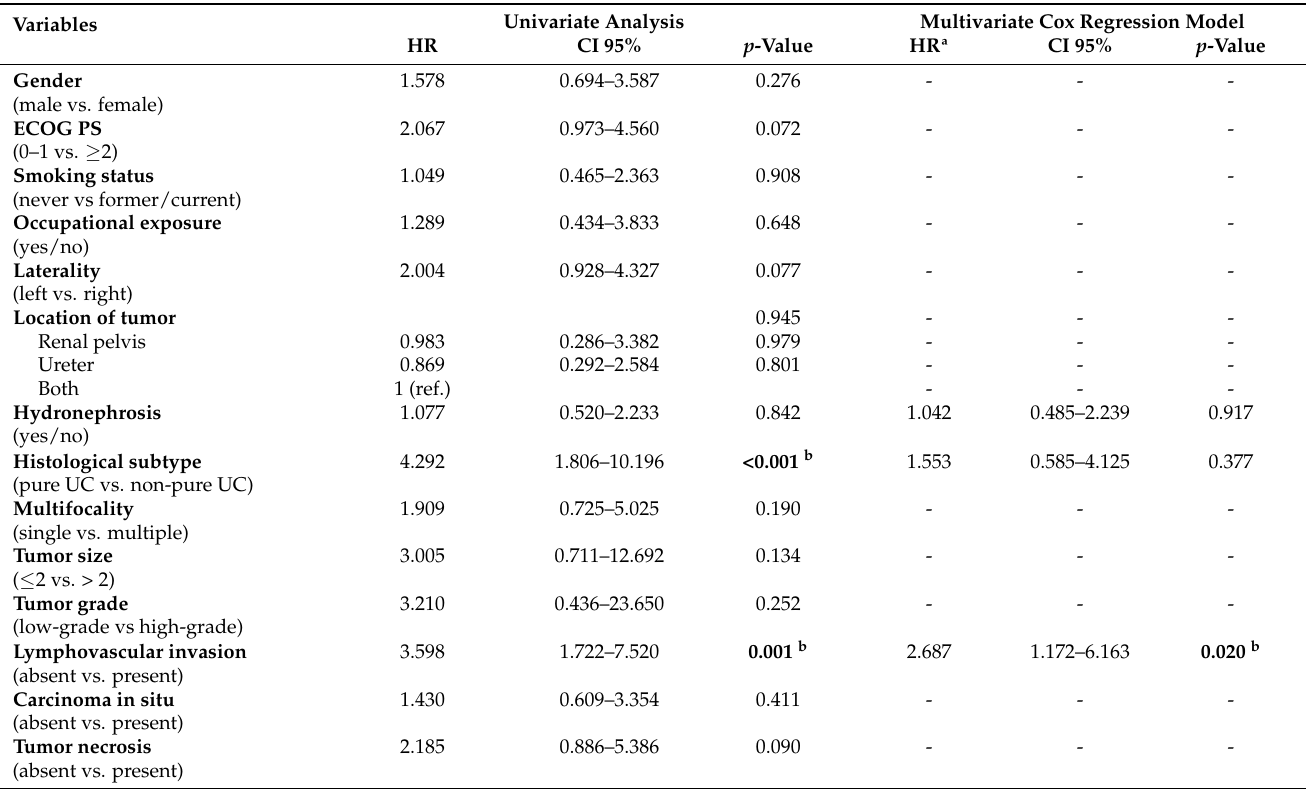
Figure 2. Kaplan–Meier curves for overall survival (OS) of patients with UTUC ( A ) and stratified according to the two subgroups—only UTUC (blue line) vs. UTUC + UBC (yellow line) ( B ). Abbreviations: UBC—urothelial bladder cancer; UTUC—upper tract urothelial carcinoma. Table 2. Univariate and multivariate Cox regression analysis of prognostic factors for